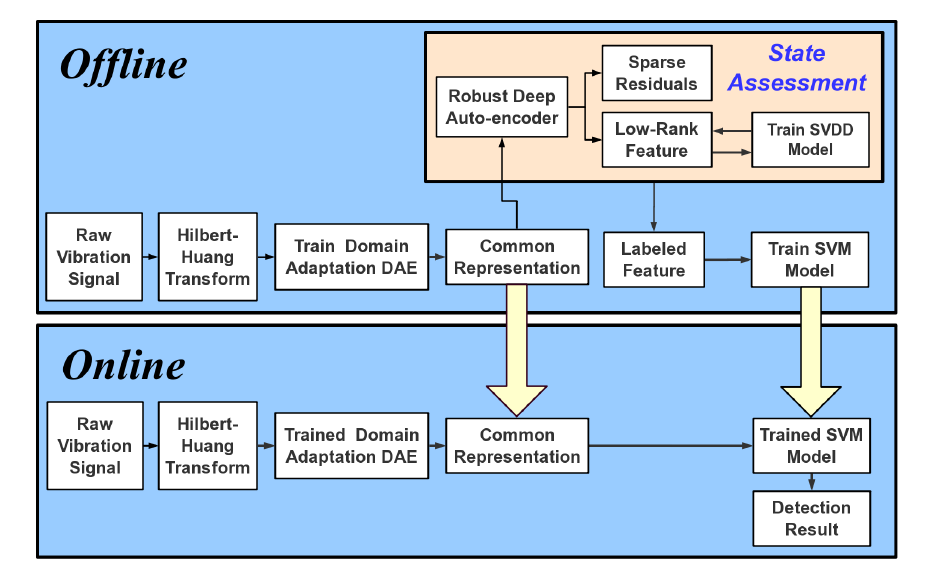
Figure 6. Flow chart of the proposed